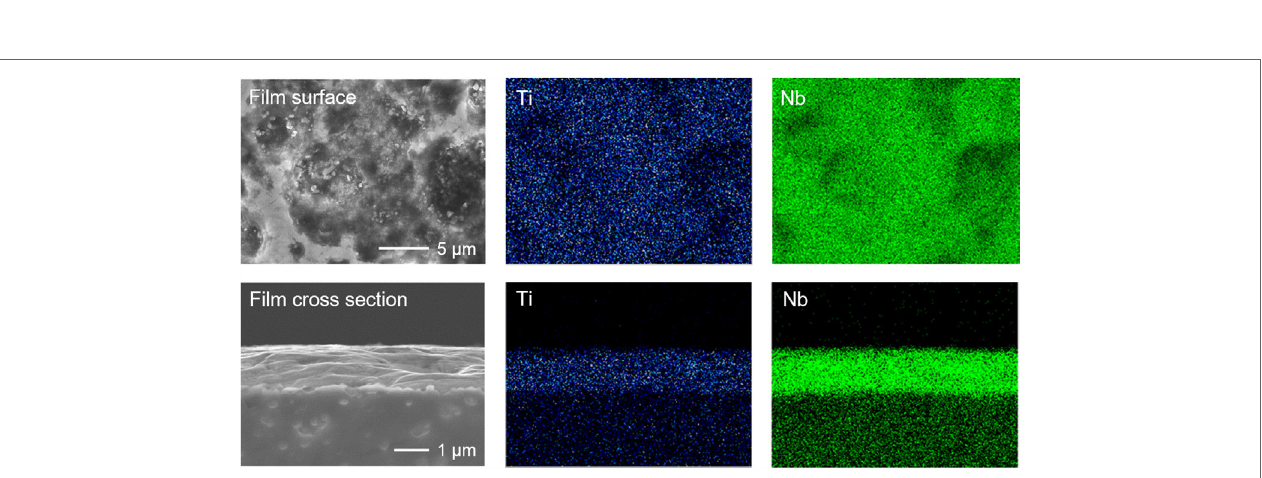
FigUre 11 | seM images and corresponding elementary mapping for Ti and nb on the surface and polished cross section of TnO film electrode formed on llBZT .